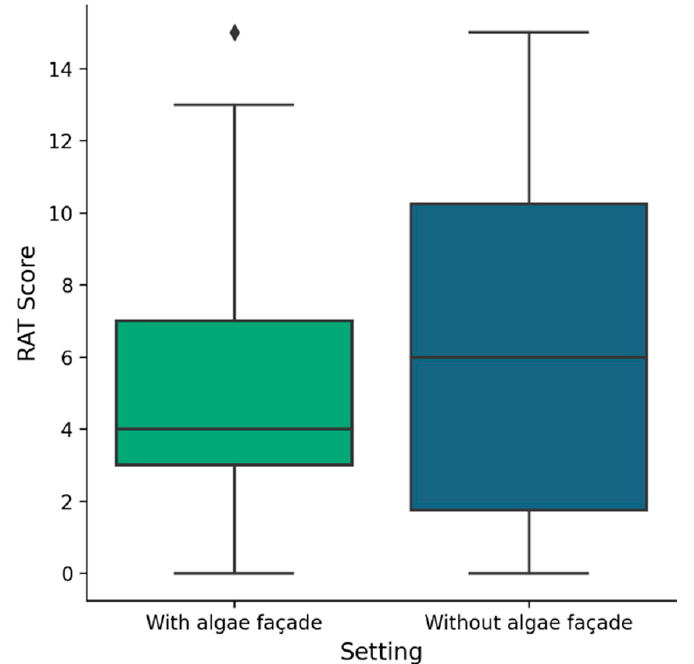
Figure 6. Effect of the algae facade on the RAT score; the microalgae façade did not have a greater impact on convergent thinking than the controlled group.